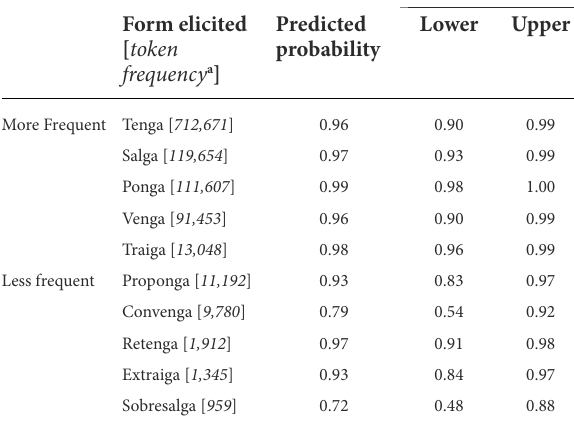
TABLE 2 Predicted probability of subjunctive use as a function of token